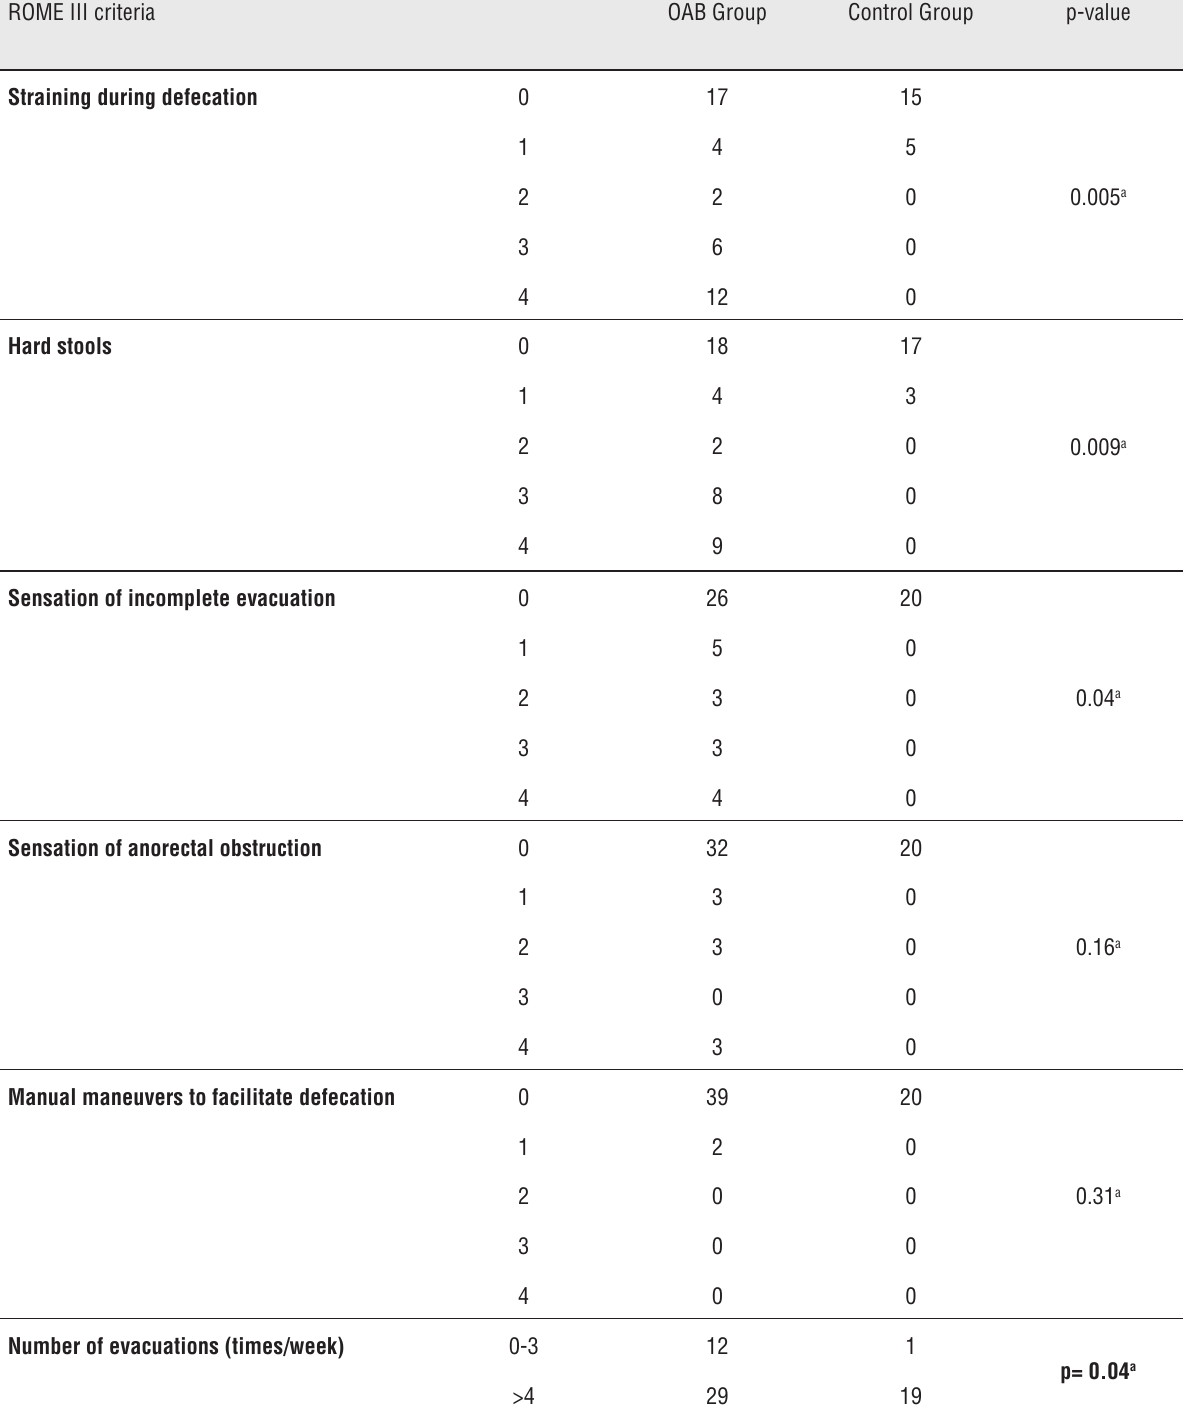
Table 1 - Frequency distribution of constipated participants as evaluated by the Rome III criteria in the two study groups. ROME III criteria OAB Group Control Group p-value